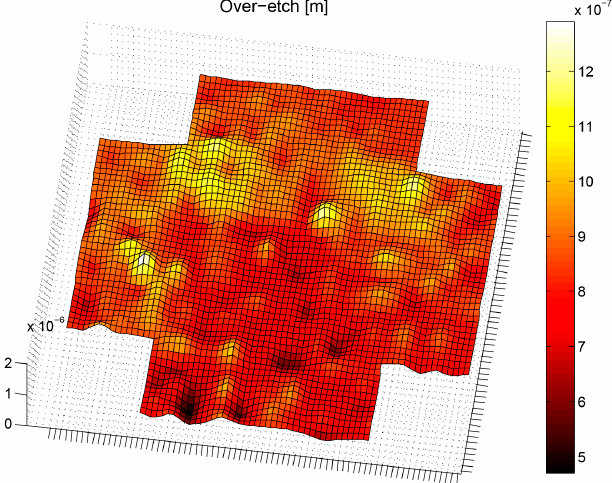
Figure 17. Over-etch wafer map.